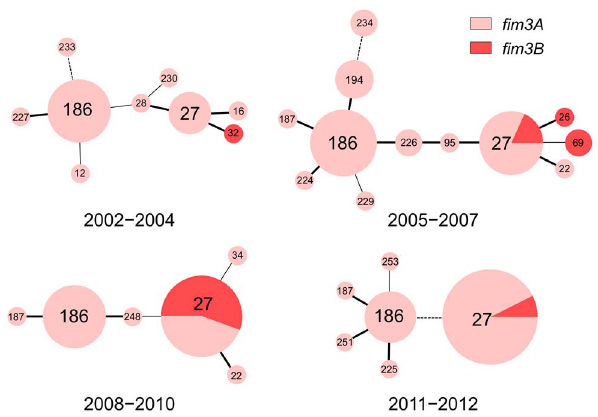
Figure 4. Minimum spanning trees revealing the genetic diversity of the Bordetellapertussis population in Japan from 2002 to 2012. MTs were determined for 134 B. pertussis isolates. The resultant phylogenetic trees based on MTs are shown by time period: 2002 2 2004 (non-epidemic, n=23), 2005 2 2007 (pre-epidemic, n=39), 2008 2 2010 (epidemic, n=33), and 2011 2 2012 (post-epidemic, n=39). Each circle within a tree represents a different MT, with the MT number noted. Thick lines separate single-locus variants, while thin lines separate double-locus variants, and dotted lines signify a more distant relationship. Pink and red colors indicate, respectively, the fim3A and fim3B allele frequencies within MTs.